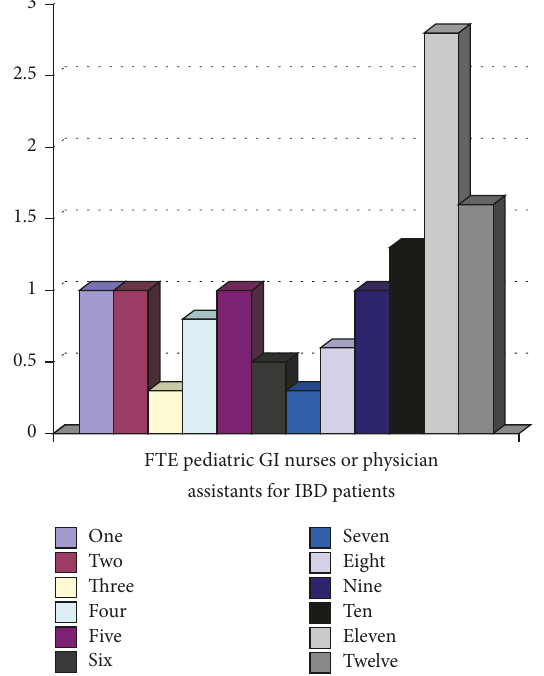
Figure 2: Full-time equivalent (FTE) nurses for children with IBD per centre.